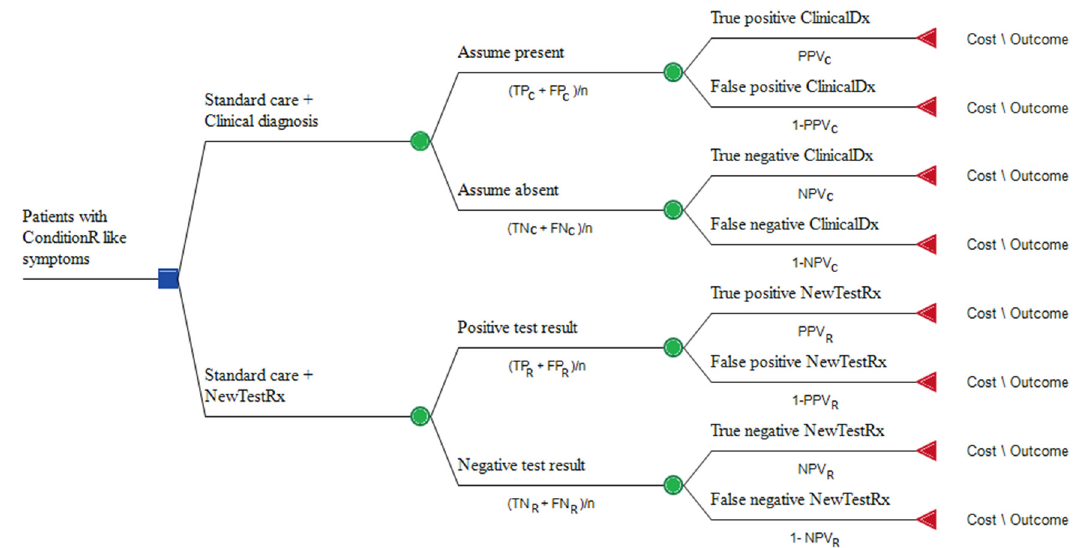
Figure 4. Simple decision tree comparing standard care with standard care plus NewTestRx for ConditionR. TP = number of true positive results, FP = number of false positive results, TN = number of true negative results, FN = number of false negative results, n = total number of patients in that path, PPV = positive predictive value, NPV = negative predictive value. Subscripts (C for clinical diagnosis and R for diagnosis with NewTestRx) identify the relevant branch for TP, FP, FN, TN, PPV, and NPV.